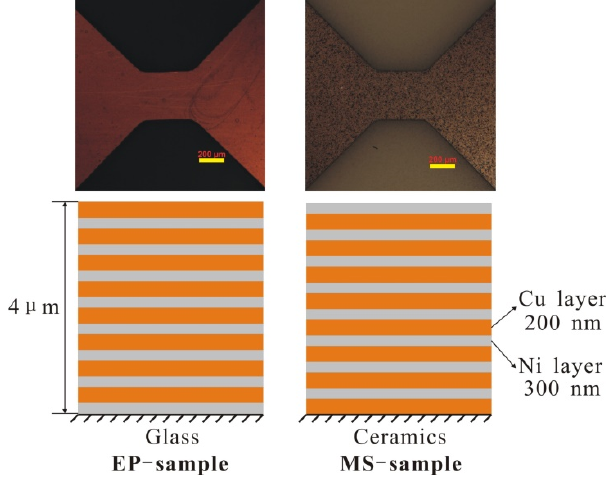
Figure 1. The initial morphology (face view, scale bar: 200 nm) and the diagrammatic sketch (side view) of two samples.